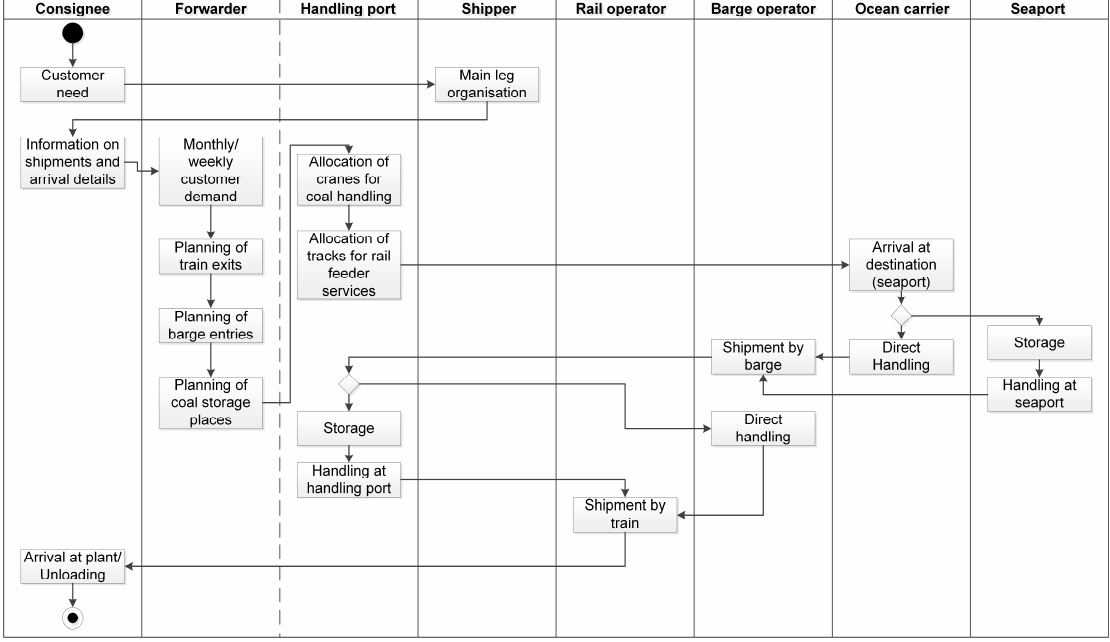
Figure 8. Activity diagram of the transshipment use case example.